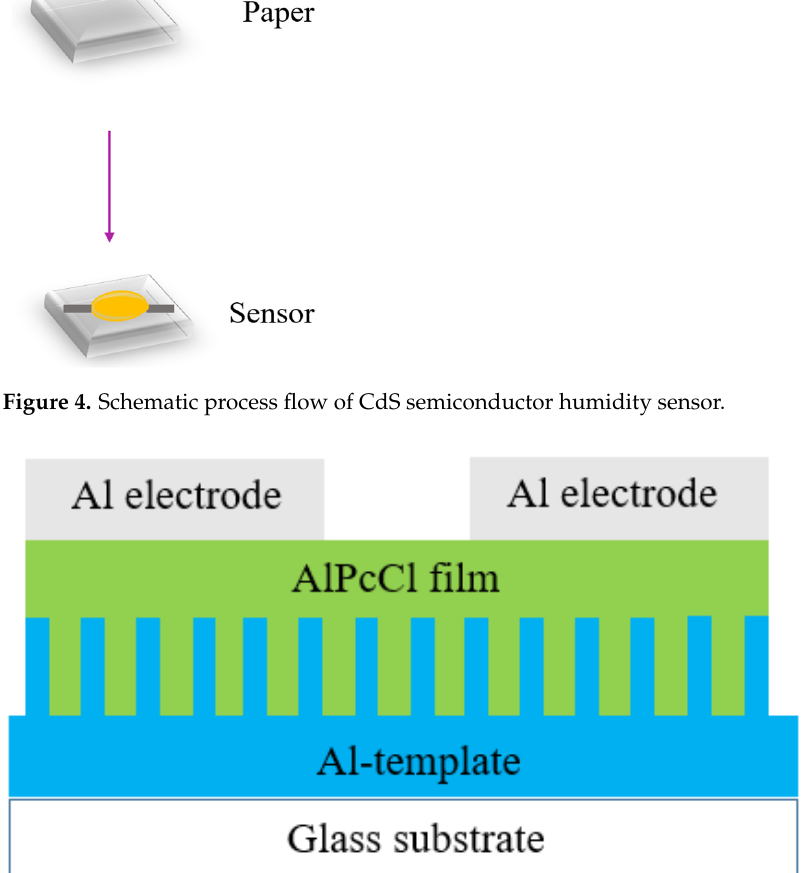
Figure 4. Schematic process flow of CdS semiconductor humidity sensor.